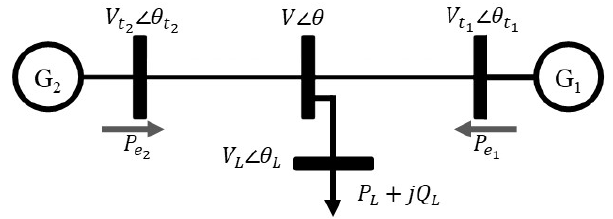
Figure 2. Interconnected power